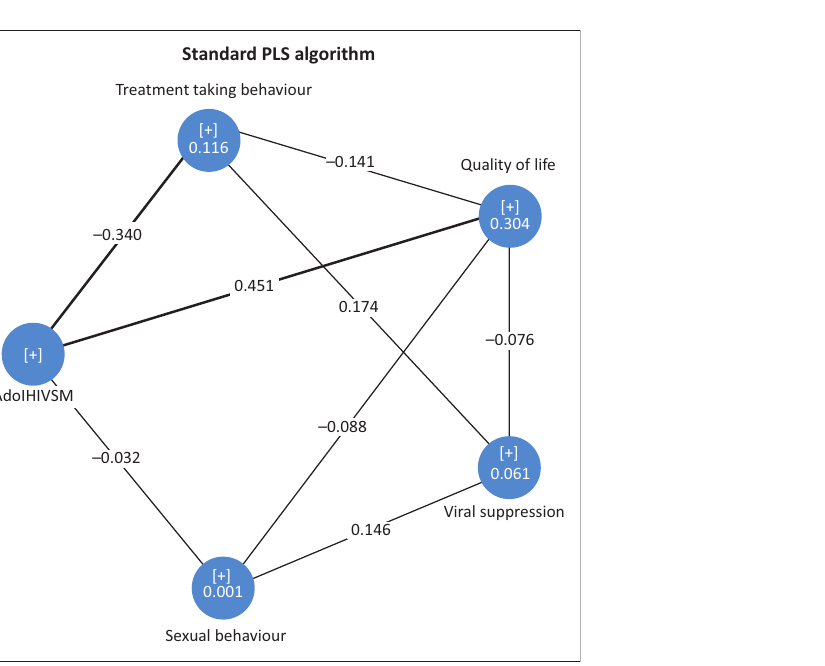
FIGURE 2-A1: Model without